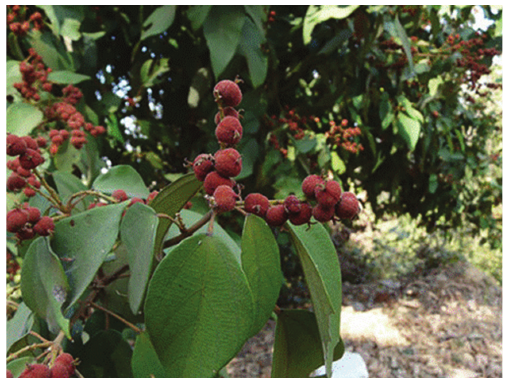
Figure 1: The Kamala tree.